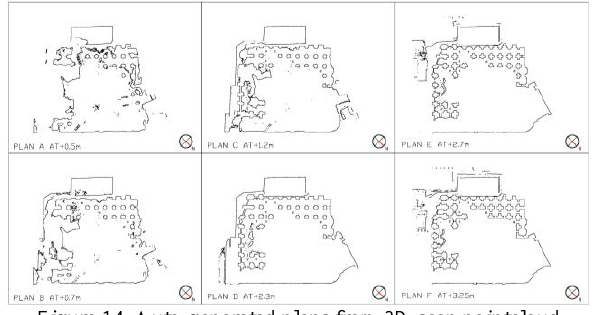
Figure 14. Auto-generated plans from 3D scan